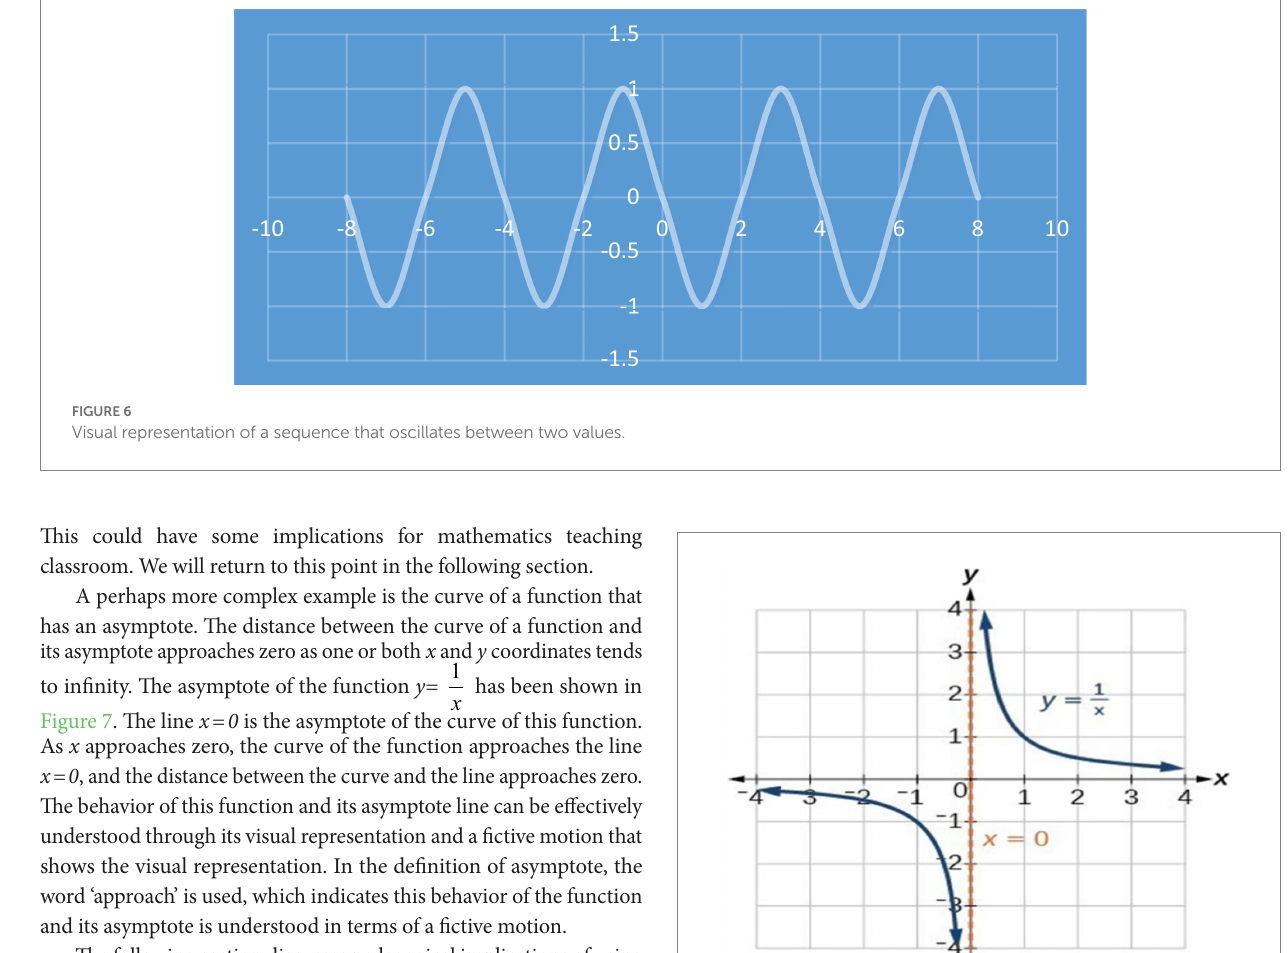
FIGURE 7 Visual representation of the function y= 1